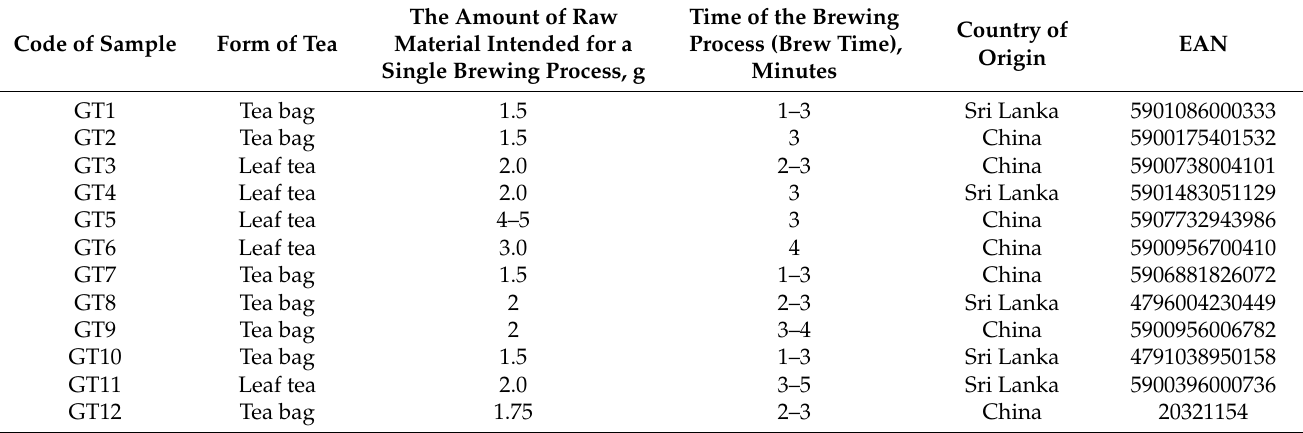
Table 1. List and data of teas used for the impurity profile and toxicological risk